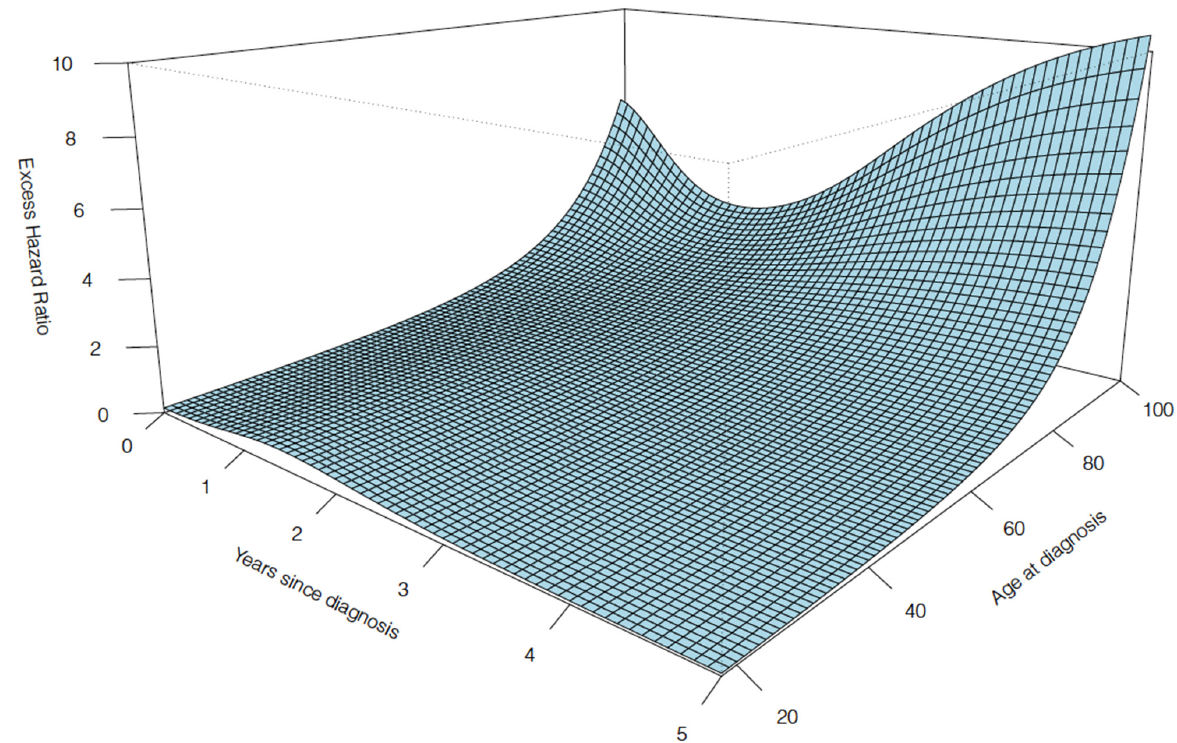
Figure A3. Excess mortality hazard ratio according to age at diagnosis and time since diagnosis for patients diagnosed with diffuse large B-cell lymphoma ( n = 29,898) in England between 2005 and 2013.